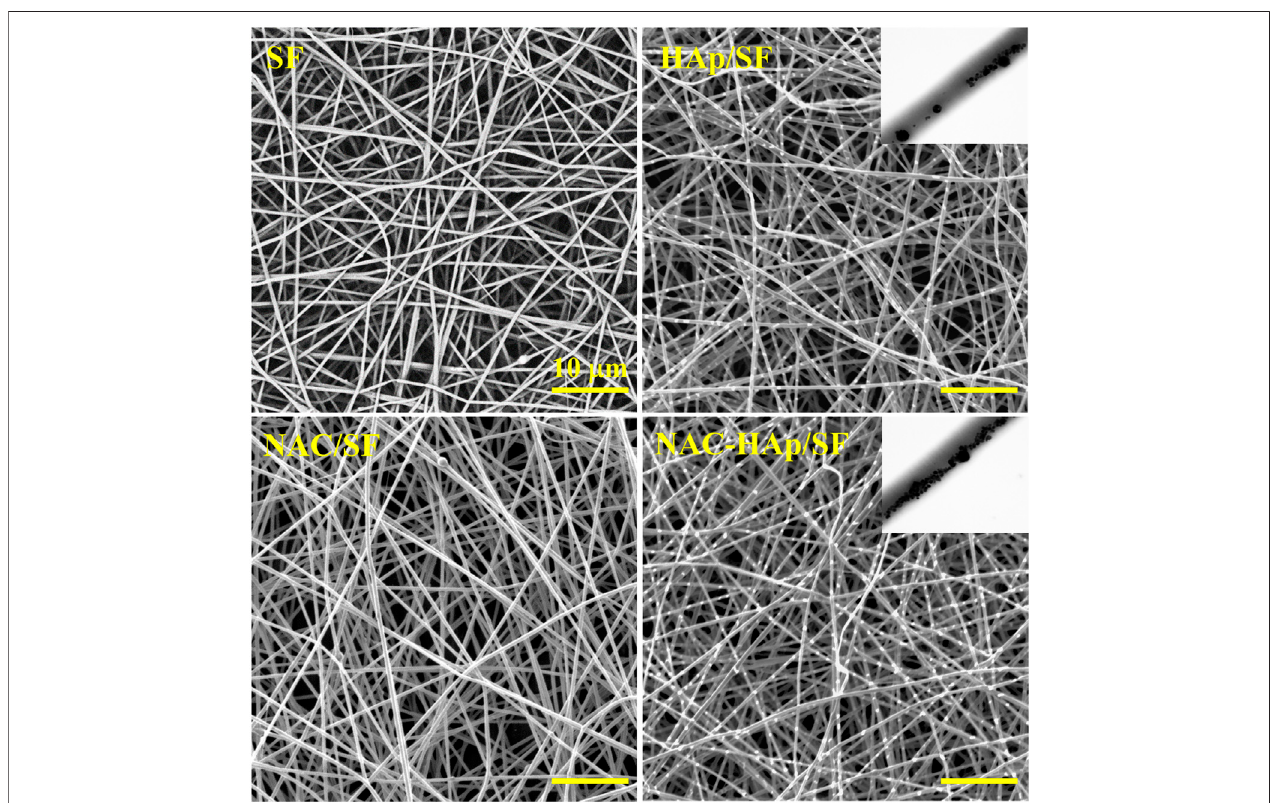
FIGURE 1 | SEM images of the pure SF, HAp/SF, NAC/SF, and NAC/HAp/SF scaffolds; the insets are corresponding TEM images.